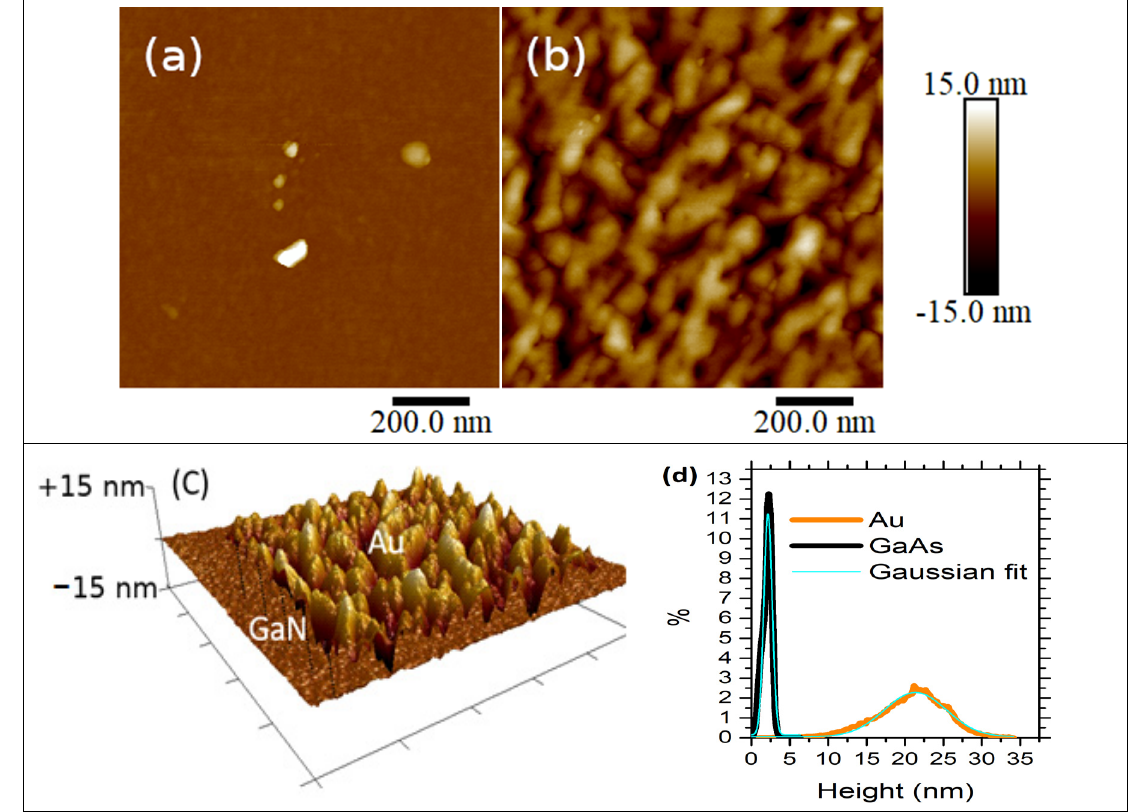
Figure 1. PeakForce tapping AFM topography for ( a ) GaN, and ( b ) Au surfaces. ( c ) Rendered illuminated 3D AFM image of GaN/Au frontier. ( d ) Height distribution functions obtained from the topography